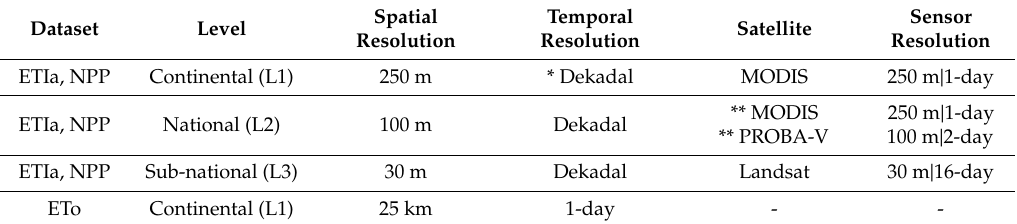
Table 2. Description of the Water Productivity Open Access Portal (WaPOR) V2.0 evapotranspiration and interception (ETIa) and net primary productivity (NPP) data products, available on the WaPOR portal